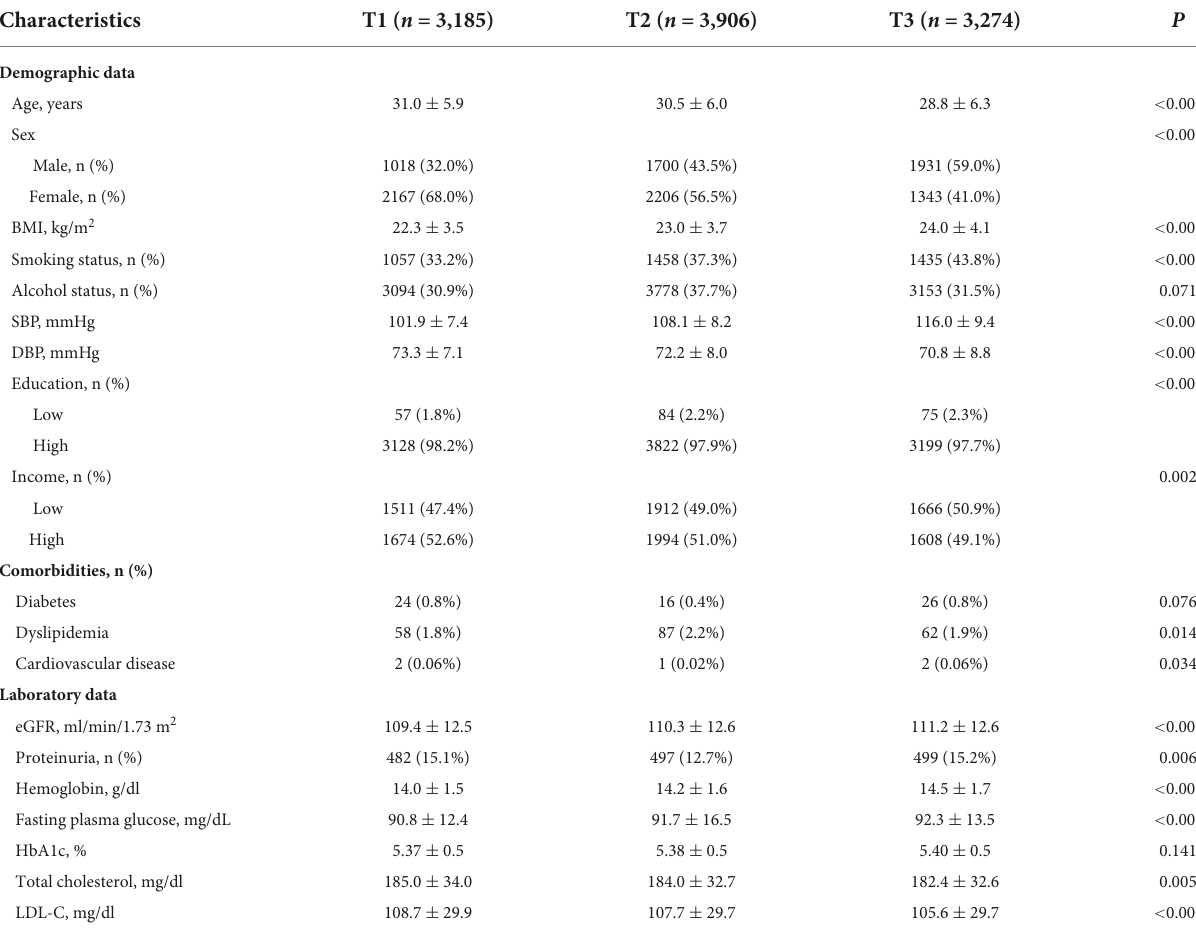
TABLE 1 Baseline